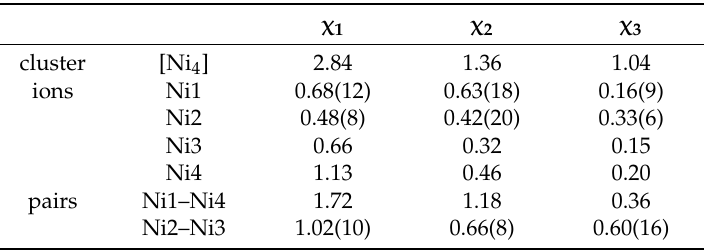
Table 4. Eigenvalues of the susceptibility tensors in ( µ B /T) from PND for the cluster, individual ions, and antiferromagnetic